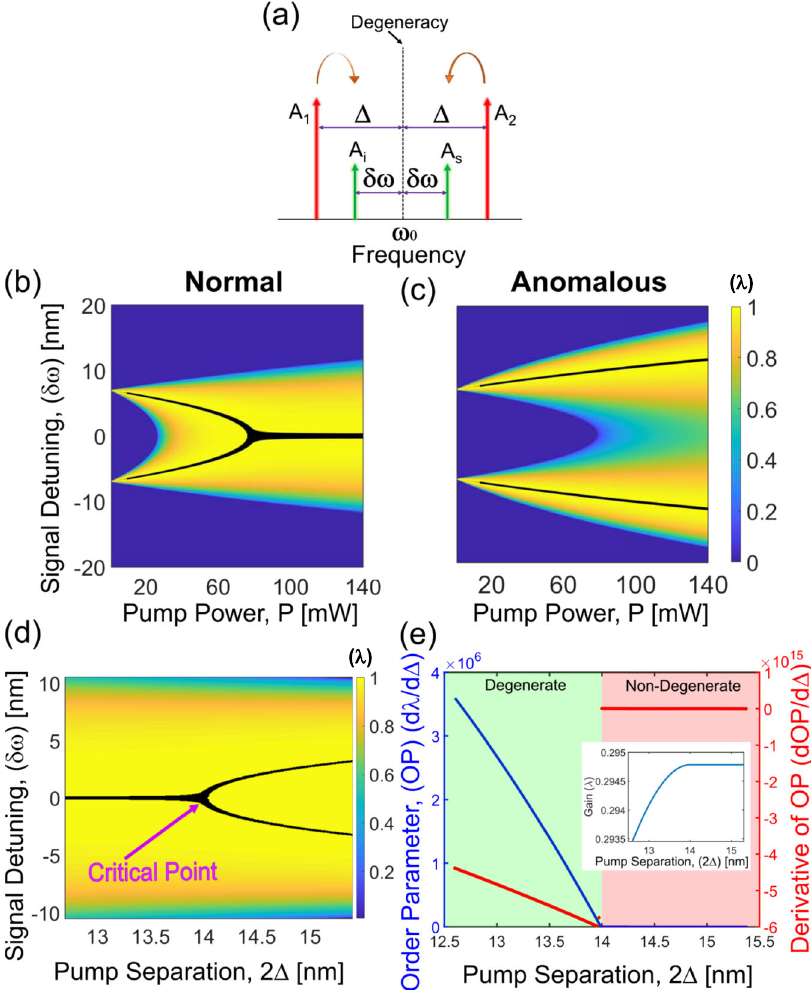
the signal/idler is supposed to oscillate is marked by the black lines. Degenerate and non-degenerate oscillations are both expected in this case. c The phase transition (normal dispersion regime) as the pump separation ( Δ ) is varied. A degenerate to non-degenerate transition happens across the critical point. e The critical point is characterized to be a second-order which displays continuous behavior in order parameter but exhibits discontinuity in its derivative. Parameters used in the simulation are taken from ref. 42